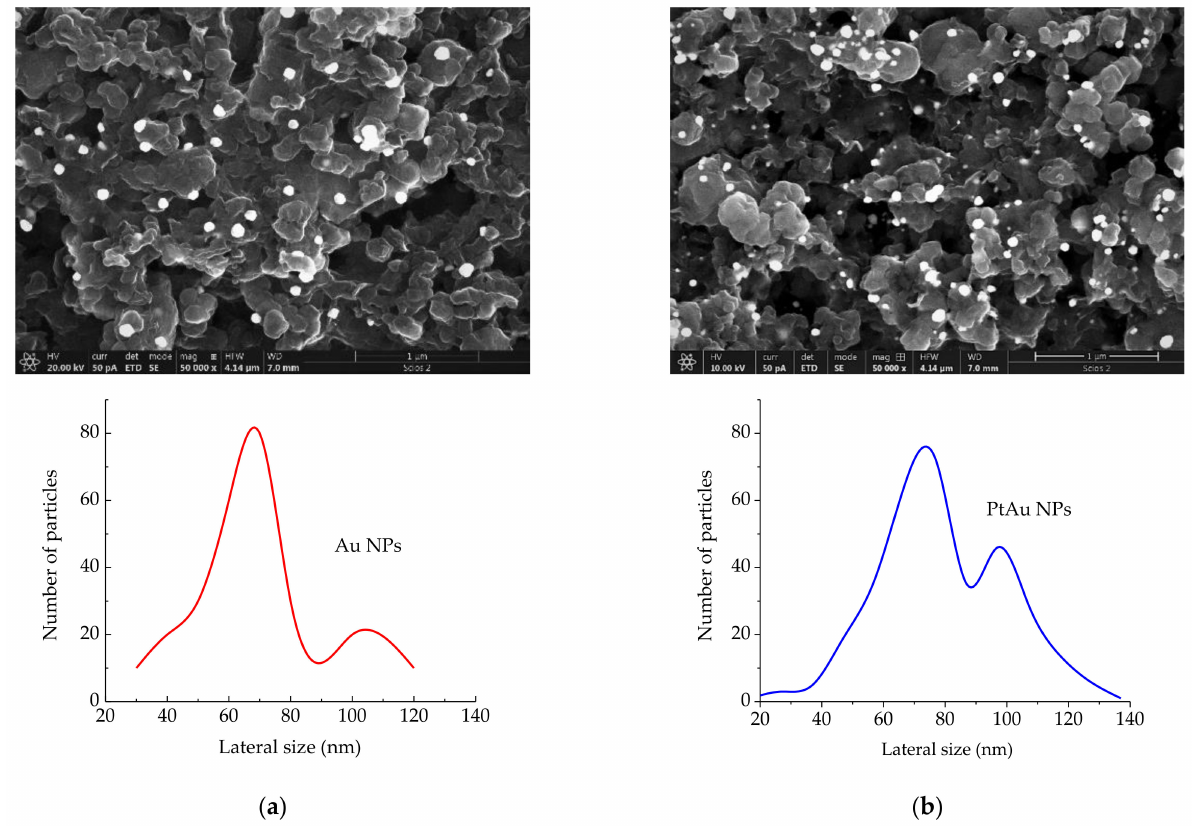
Figure 1. SEM images (magnification = 50,000 × , scale-bar = 1 µ m) of: ( a ) Au/rGO and Au NPs size distribution; ( b ) PtAu/rGO and PtAu NPs size